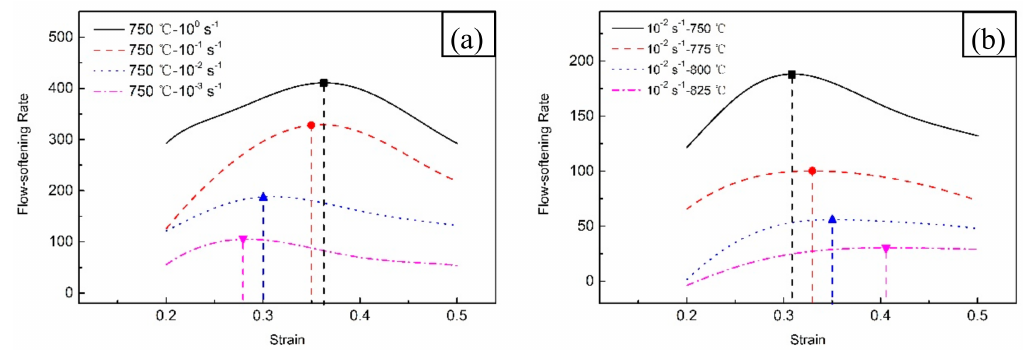
Figure 3. Relationship of the flow softening rate − d σ /d ε versus strain ε at 750–825 ◦ C and 10 − 3 − 1 s − 1 .